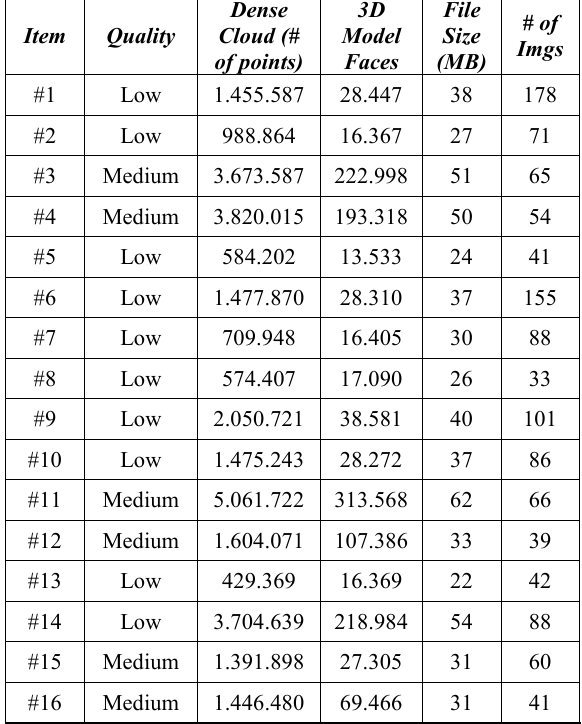
Table 4: The quantitative details of the 3D